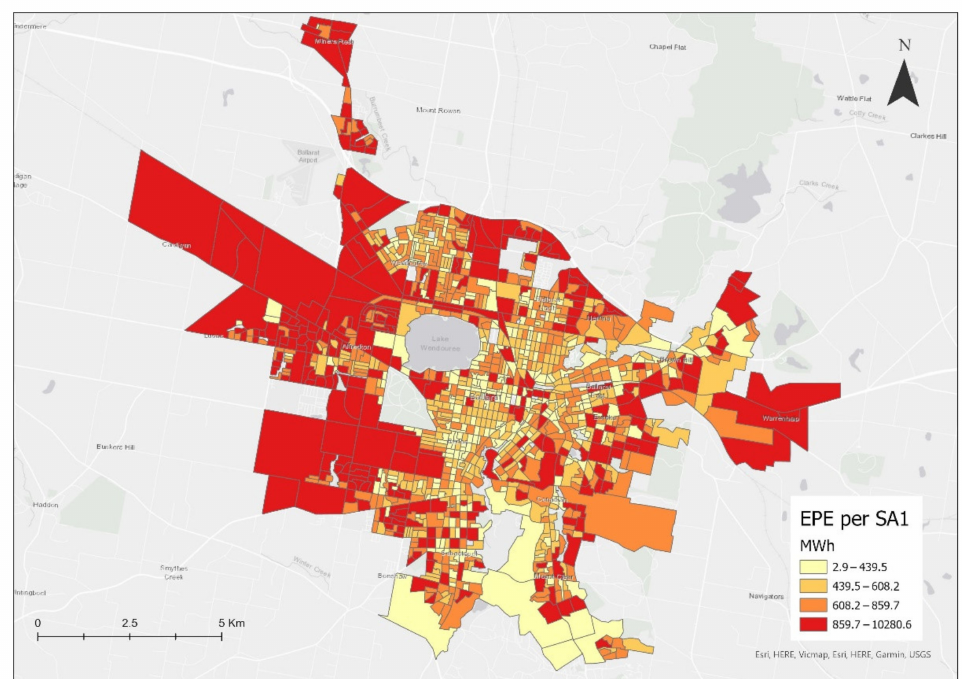
Figure 9. Spatial distribution of the EPE at the SA1